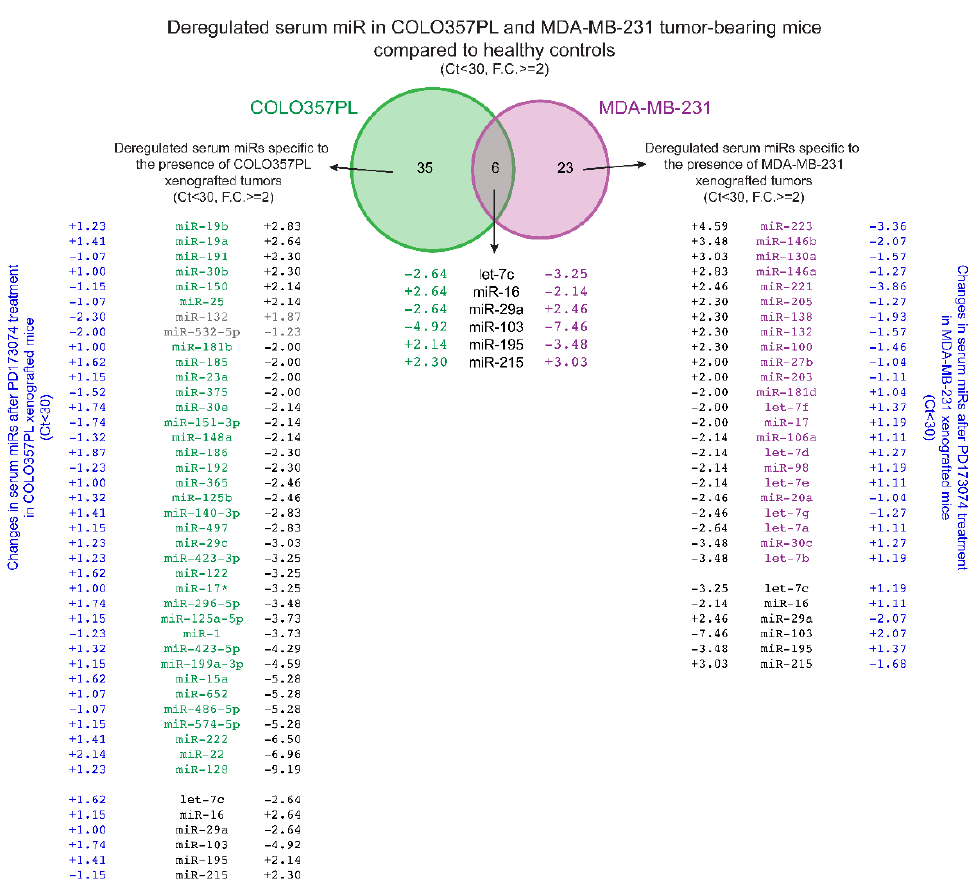
Figure 4. Venn diagram of serum miRs related to the presence of COLO357PL and MDA-MB-231 xenograft tumors, and serum miRs related to the short-term treatment with the FGFR inhibitor, PD173074. The expression levels of 352 serum miRs in COLO357PL (green) and 88 serum miRs in the MDA-MB-231 (magenta) xenograft mouse model were analyzed by qPCR and normalized for respective median Ct value. miRs with Ct < 30 that were changed by ≥ 2-fold are presented. Additionally, serum miRs changes after short-term treatment with PD173074 (blue) in both xenograft models are presented. Fold changes in serum miR expression after the PD173074 treatment are presented for every tumor-related miR with Ct < 30, as well as those that are ≥ 2-fold deregulated after PD173074 treatment.